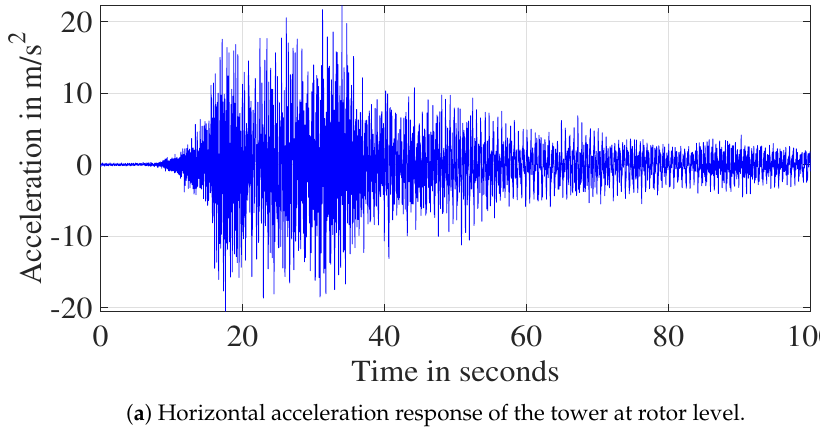
( a ) Horizontal acceleration response of the tower at rotor level.